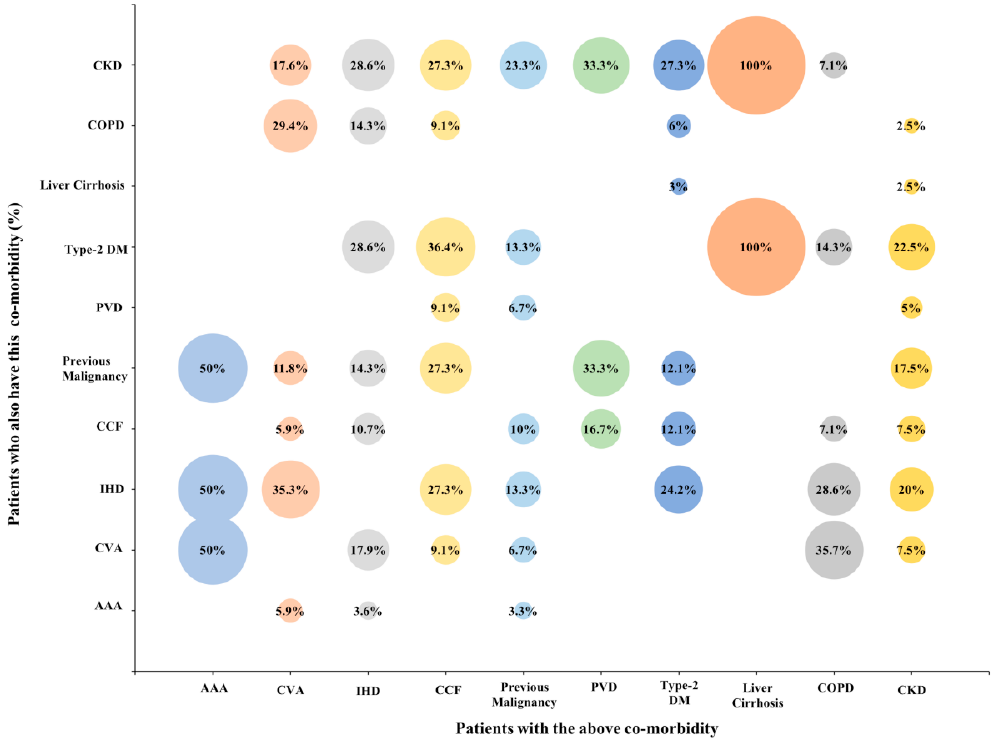
Figure 2. The number of significant comorbidities by age-group.